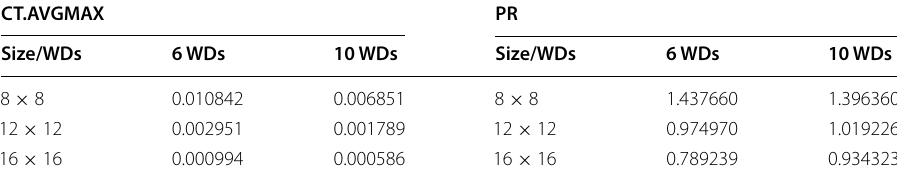
Table 2 The values of CT.AVGMAX and